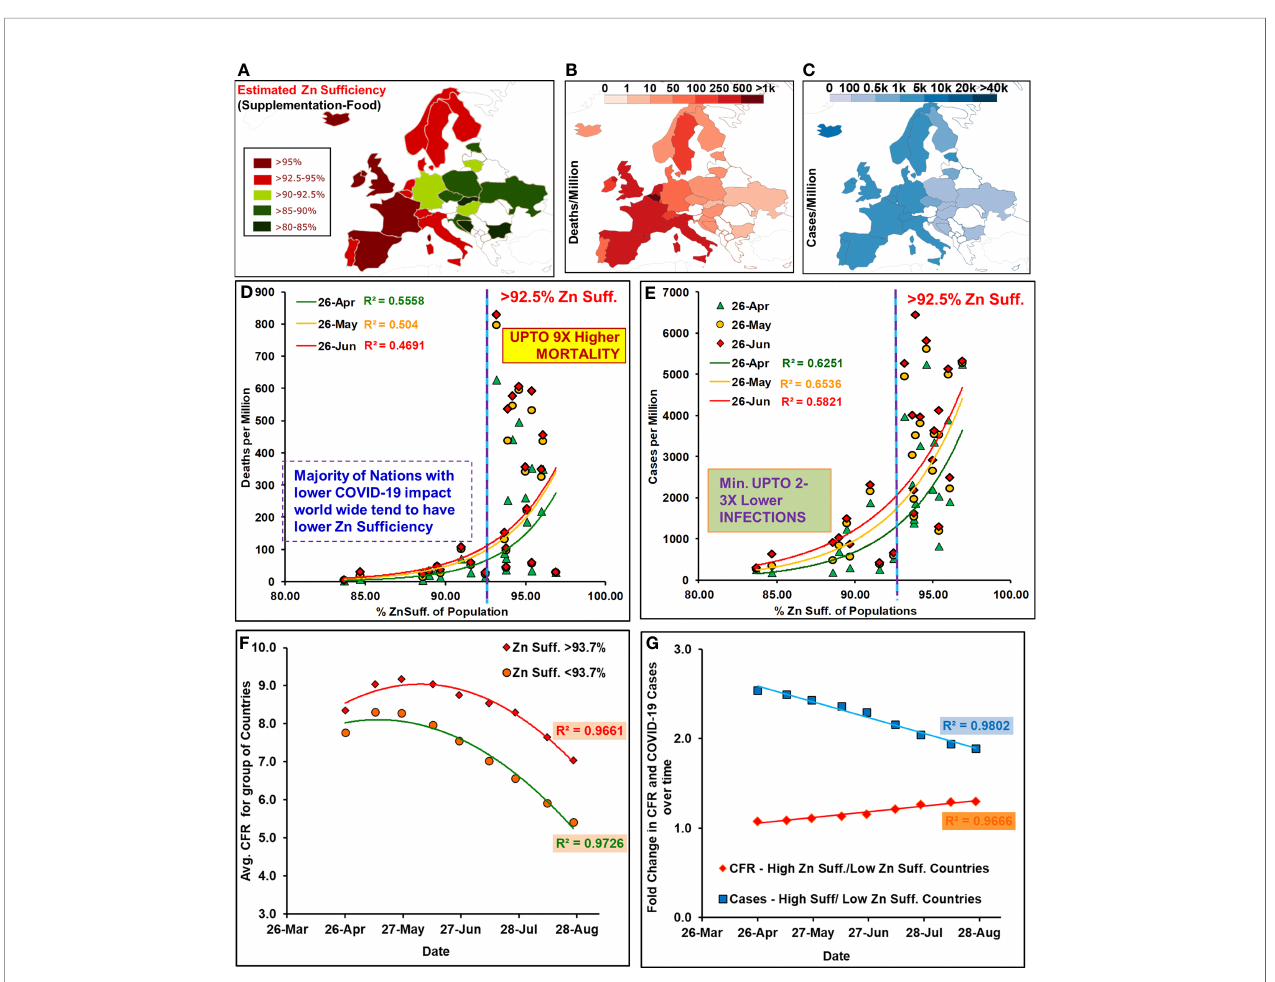
FIGURE 1 | Zinc suf fi ciency of the socially similar European populations correlated with COVID-19 mortality. Study populations: (A) Zn suf fi ciency estimates, (B , C) deaths and cases/million (April 26). [Note: Global maps [18] displayed color scheme variations performed using “ Inkscape ” ]. Deaths (D) and cases (E) per million population positively correlated with their Zn suf fi ciency levels. (F) For the group of countries with different Zn suf fi ciency (suff.) the interim case fatality ratio [i-CFR or Avg. CFR = (reported deaths/reported cases) * 100] remained different throughout the period after peaking in May 2020. (G) Fold change in the relative CFR for high suff. with respect to low suff. countries have been registering a steady increase while the gap for cases has kept